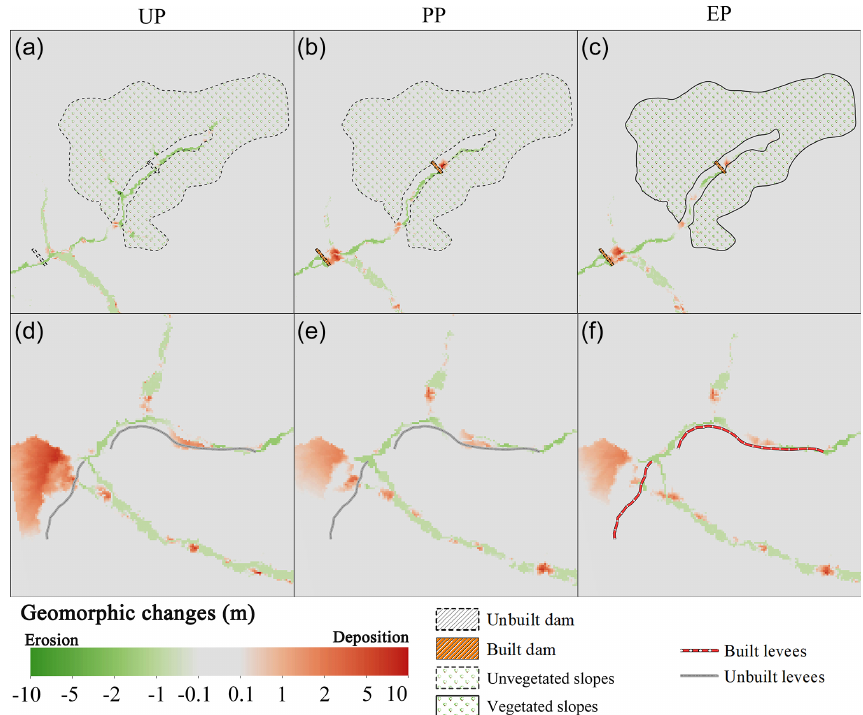
Figure 7. Geomorphic changes at key locations of the simulation results for the UP, PP and EP scenarios. (a, b, c) The upriver extent containing dam 1, dam 2 and the vegetated slopes. (d, e, f) The downriver extent containing levees.